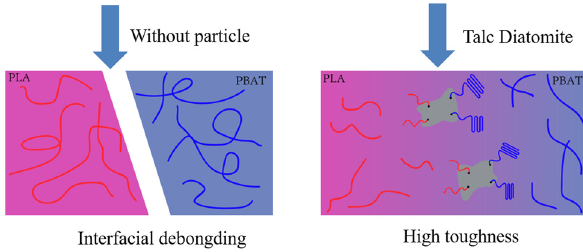
Figure 6: Scheme of toughening mechanism of the